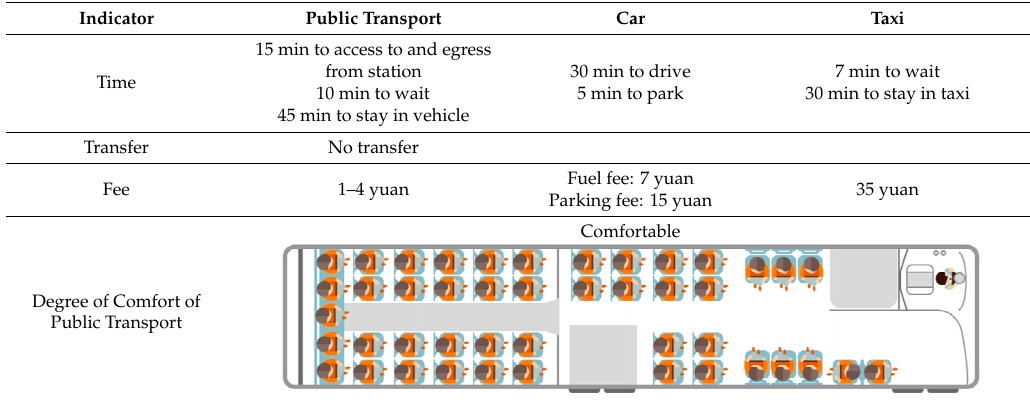
Table 5. Schematic of scenario 6.